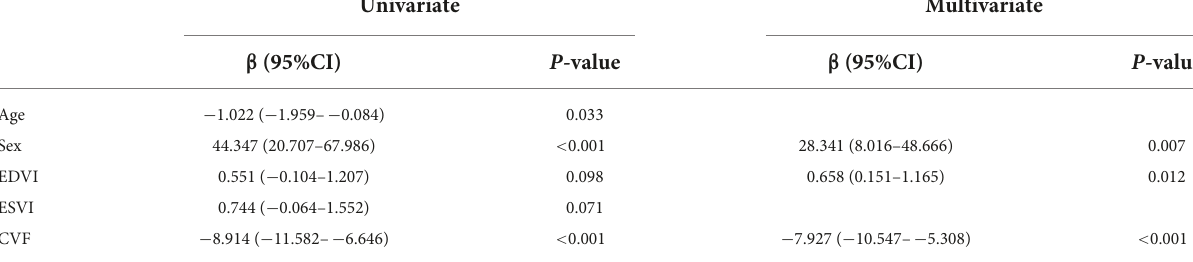
TABLE 3 Univariate and multivariate regression analyses for peak of emptying rate (PER-E) in patients with hypertrophic obstructive cardiomyopathy (HOCM). Univariate